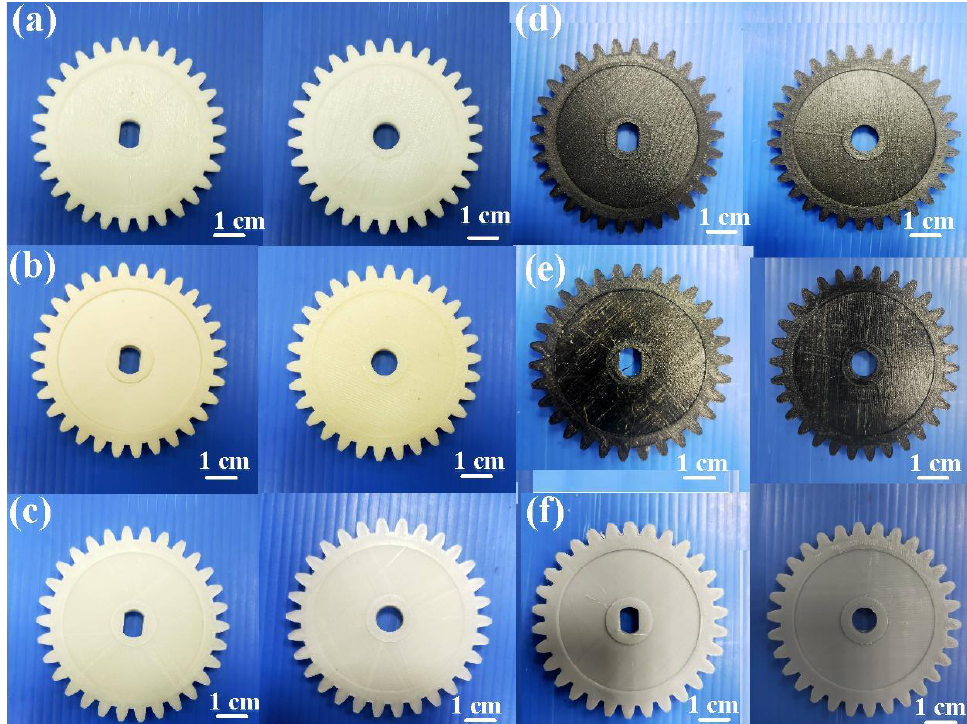
Figure 15. Typical spur gears fabricated with six different filaments of ( a ) PLA, ( b ) ABS, ( c ) 10 wt.% glass fiber-reinforced PLA, ( d ) 10 wt.% carbon fiber-reinforced PLA, ( e ) PA, and ( f ) PC using FDM technique.